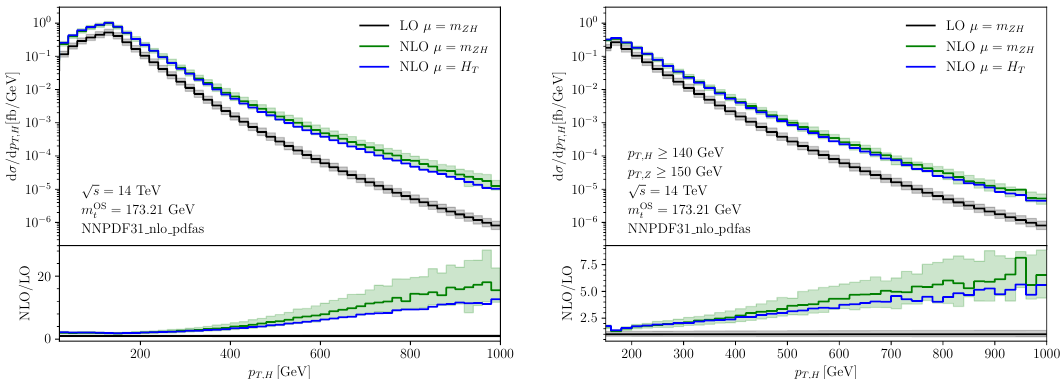
Figure 7. Higgs-boson transverse momentum distribution at LO and NLO, including scale uncer- tainties resulting from a 7-point scale variation around the central scale µ fully inclusive, right: results based on p